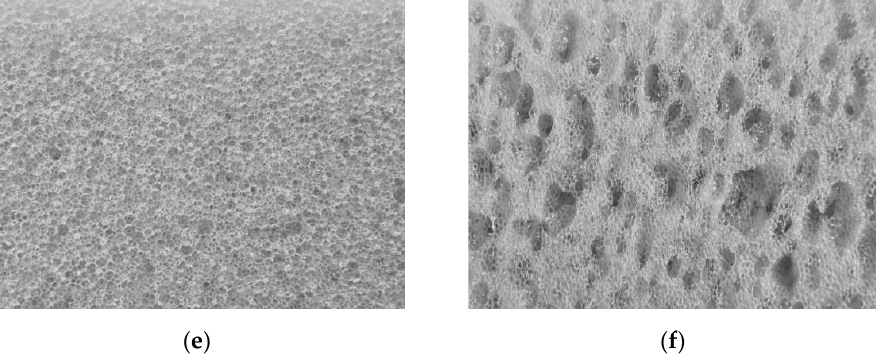
Figure 2. Pictures of the investigated polyurethane foam samples: ( a ) sample А ; ( b ) sample B; ( c ) sample C; ( d ) sample D; ( e ) sample E; ( f ) sample F. Table 1. Parameters of the investigated samples of polyurethane foams.